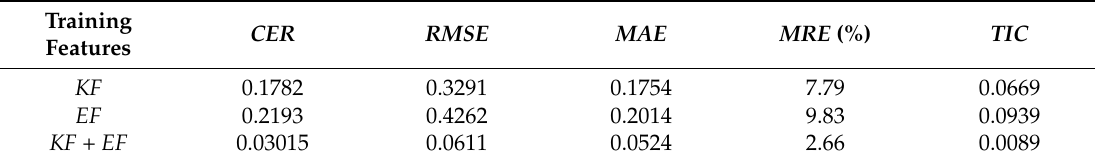
Table 1. The performance of IFOA-LSSVM on the testing set with different combinations of features.